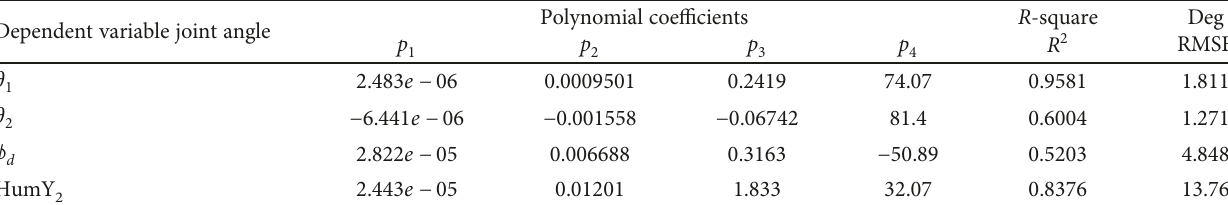
Figure 19: The joint angles are fi t using a third-order polynomial (ABD). Table 5: Third-order polynomial fi t parameters of the rhythm function